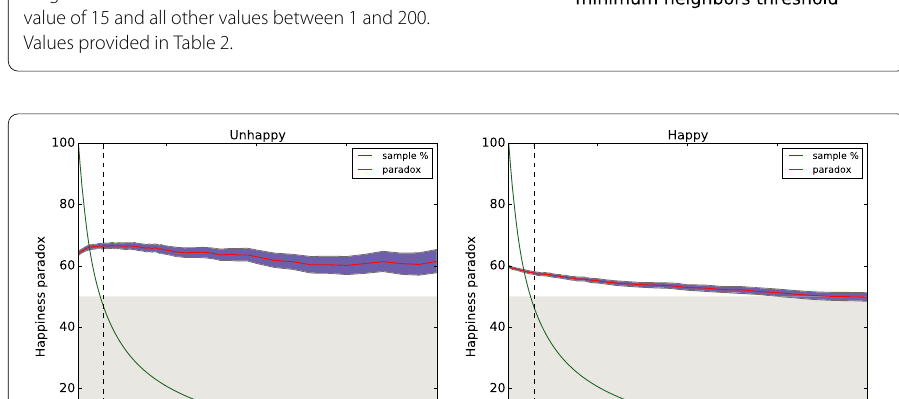
Figure 4 Minimum neighbor threshold vs. percentage of sample retained. In our calculation of the Happiness Paradox we apply a minimum neighbor threshold for each user, i.e. a minimum number of neighbors the individual must have to be included in our sample, to (1) reduce the chances of including defunct, automated, or particularly socially inactive users and (2) ensure that a mean neighbor degree or SWB is calculated on the basis of no less than 15 data points. This threshold leads to a reduction of our sample. This graph visualizes the magnitude of the reduction at chosen threshold value of 15 and all other values between 1 and 200. Values provided in Table 2.